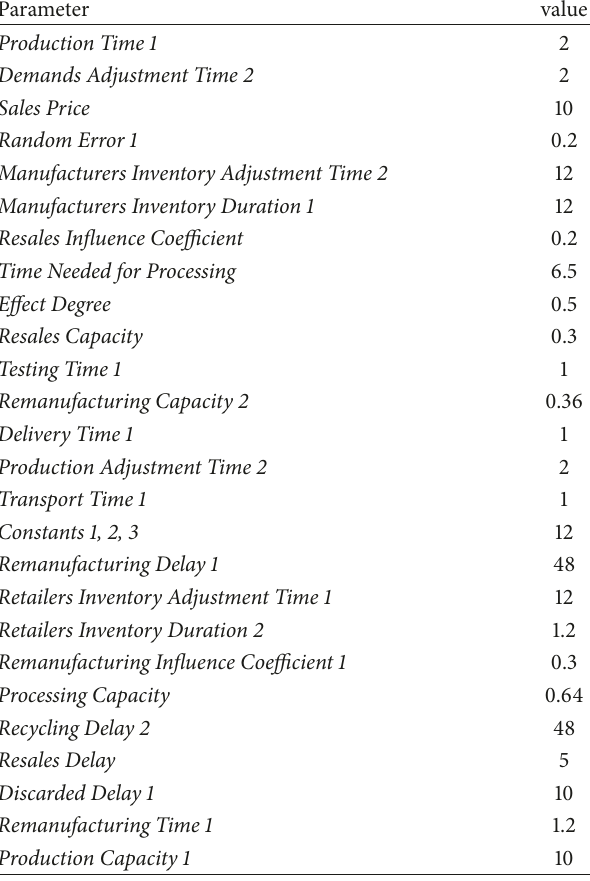
Table 1: Constants